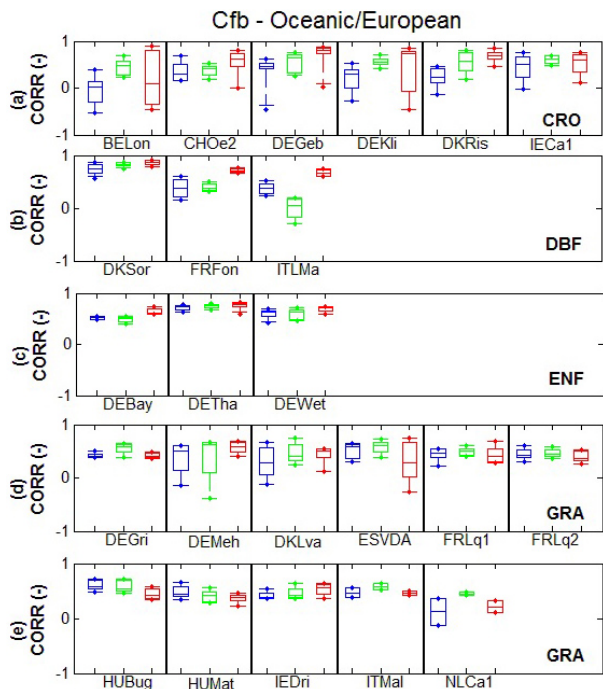
Figure 2. As in Fig. 1, except for NEE and CORR, for sites (Ta- ble 1) corresponding to the Cfb Köppen’s climate class – Temperate without dry season, with warm summer.